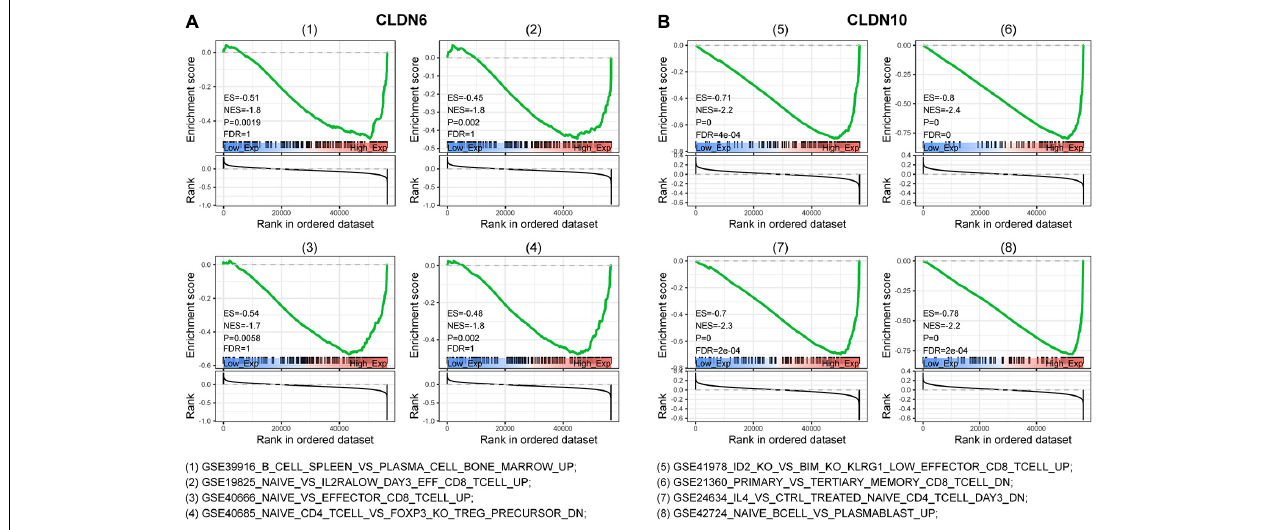
FIGURE 4 | Gene set enrichment analysis (GSEA) of c7 (immunologic signatures) for CLDN6 and CLDN10. CLDN6 (A) and CLDN10 (B) were related to effector differentiation of B cell, CD8 T cell, and CD4 T